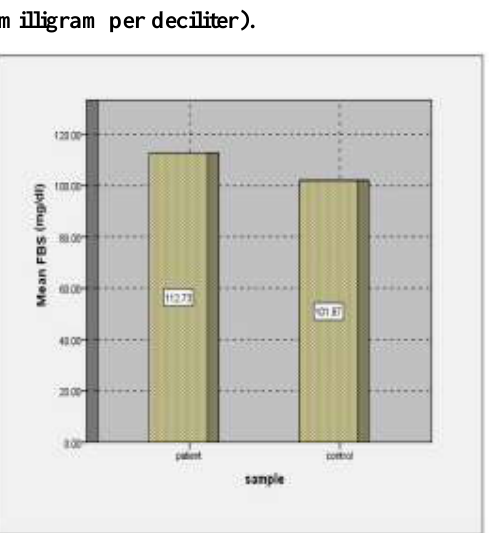
Figure 2: Mean serum high density lipoprotein (HDL) and very low density lipoprotein (VLDL) in patients with cholelithiasis and healthy controls (milligram per deciliter).